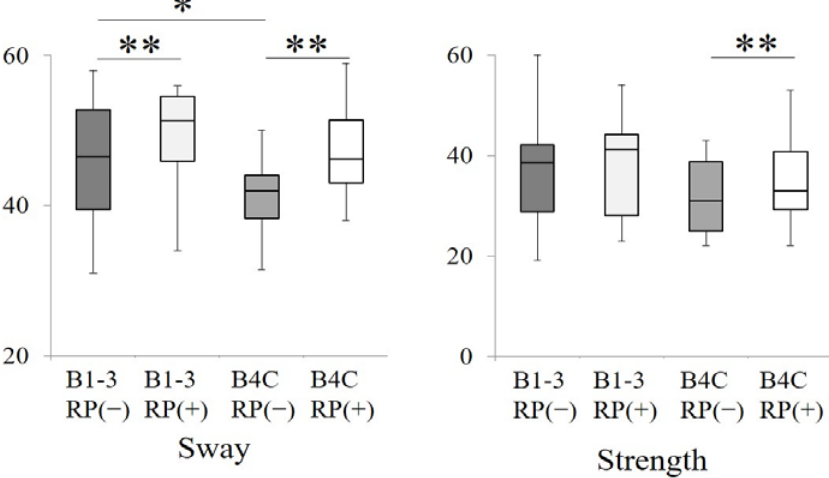
Figure 8. Comparisons of standing motion (sway and strength) between the B1–3 group and the B4C group with or without removable prostheses in each group (* p < 0.05, Mann–Whitney U test). Comparisons of standing motion (sway and strength) between subjects with and without removable prostheses in each group (B1–3 group or B4C group) (** p < 0.05, Wilcoxon signed-rank test). RP (+): subjects with removable prostheses; RP ( − ): subjects without removable prostheses.